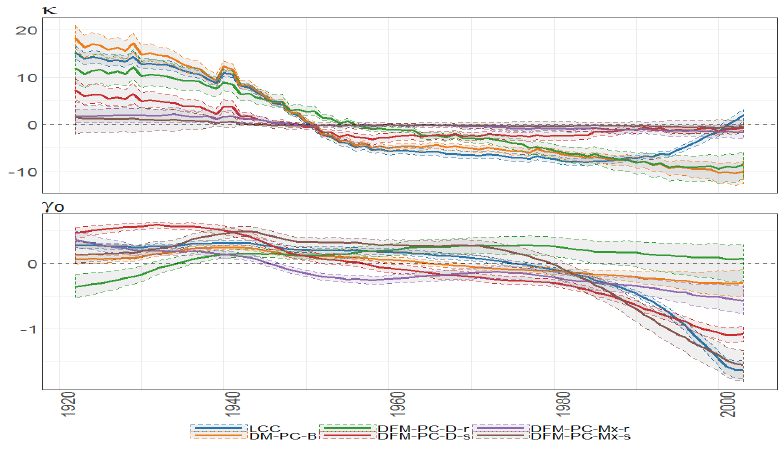
Figure 32. The Bayesian posterior mean estimates with 95% posterior credible intervals for κ t (upper panel) and cohort effect state process γ 0 (lower panel) under different models (colours of lines) t for British female log death rates during